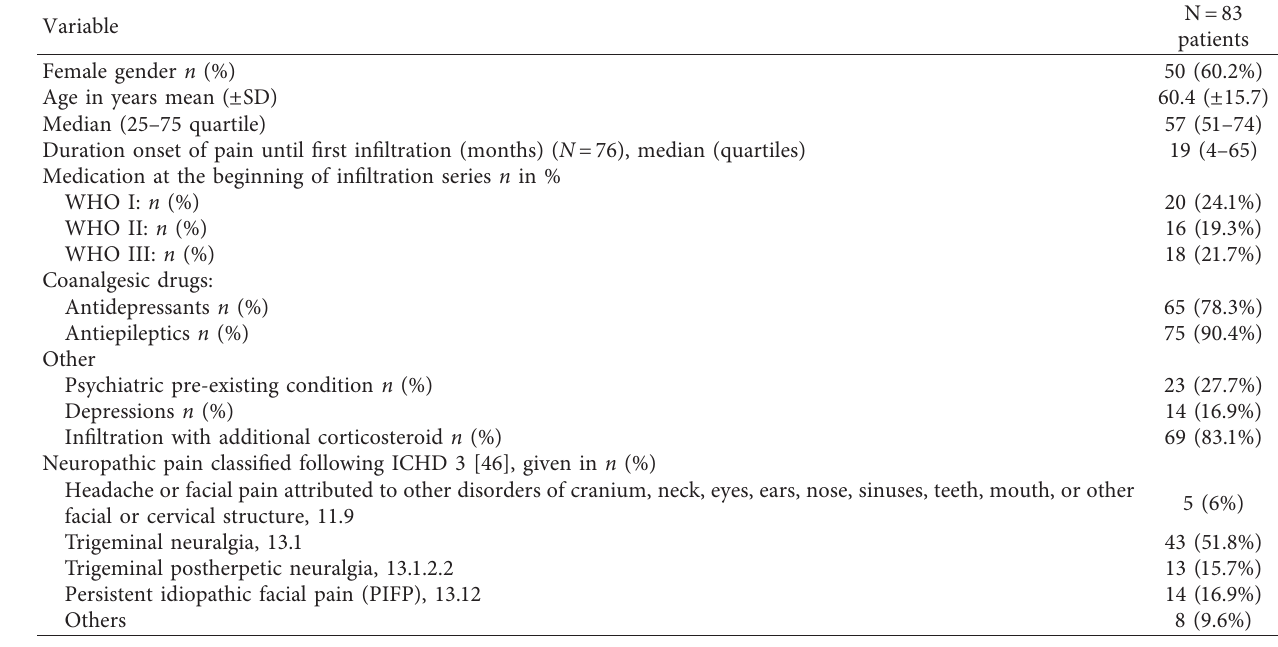
Table 1: Basic characteristics for N � 83 patients included with refractory neuropathic pain syndromes in the head-neck area.